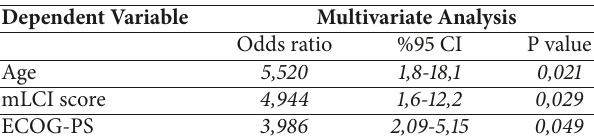
Table 3: Multivariate analysis of clinical and metabolic parameters. All variables in Table 2 were included in multivariate analysis, but only statistically significant results are presented in Table